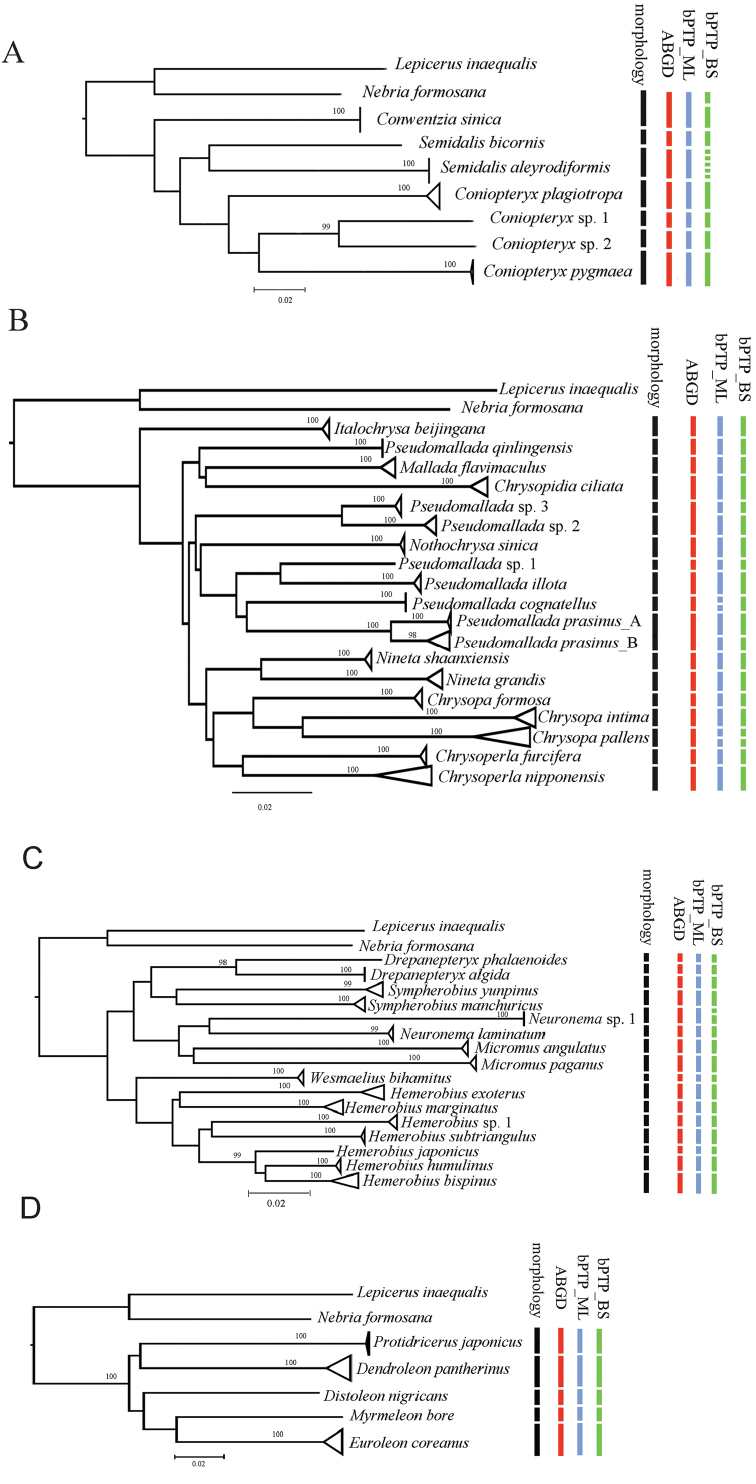
Neighbor-joining tree and result of molecular species delimitation based on COI barcodes. AConiopterygidaeBChrysopidaeCHemerobiidaeDMyrmeleontidae and Ascalaphidae. The terminal nodes in the tree are collapsed for each morphological species, the width of triangles shows the sequence divergence. Only bootstrap supports (1,000 replicates) > 0.95 are labelled.